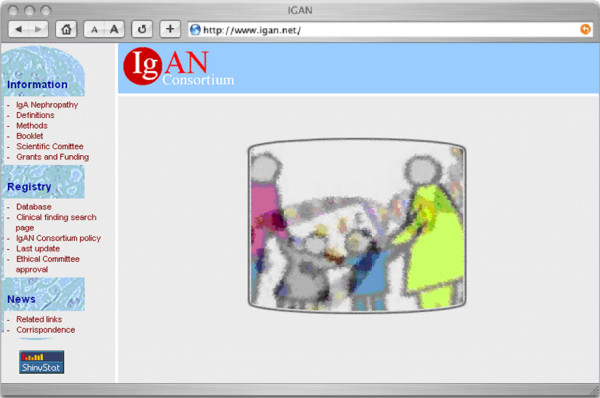
IgAN Consortium website structure.